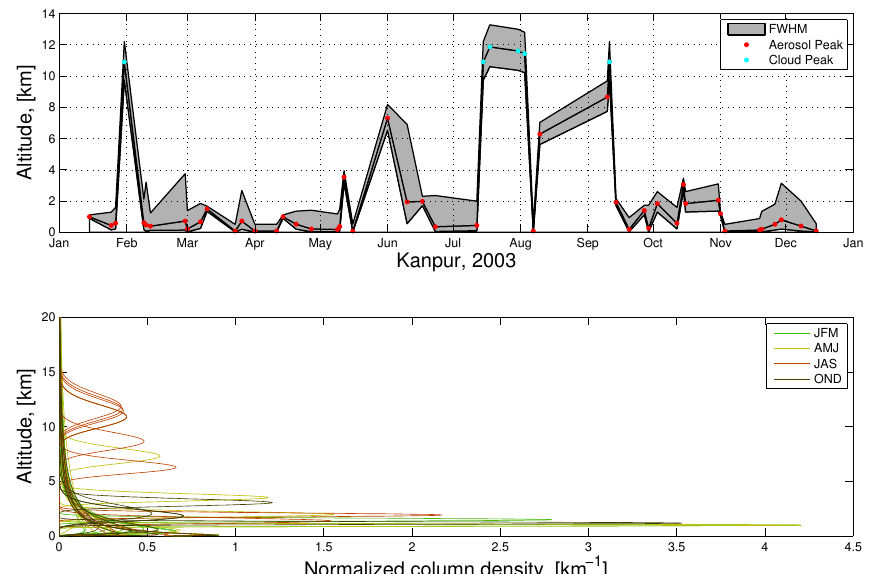
Fig. 10. Upper panel: a time series of retrieved heights of maximum aerosol concentration, represented by red dots for τ 700 < =5.0, and cyan dots for τ 700 > 5.0. The black lines bounding the gray region around the dots represent heights at which the aerosol concentration is half its maximum value. Lower panel: a representation of each lognormal vertical profile retrieved in the case-study over Kanpur. The x-axis may be regarded as the probability density function for the aerosol to be present at a given altitude, hence the unit [km − 1 ]. The retrievals are color-coded by season as shown in the legend. The wet months of July, August and September stand out due to their high altitude profiles, mostly attributable to